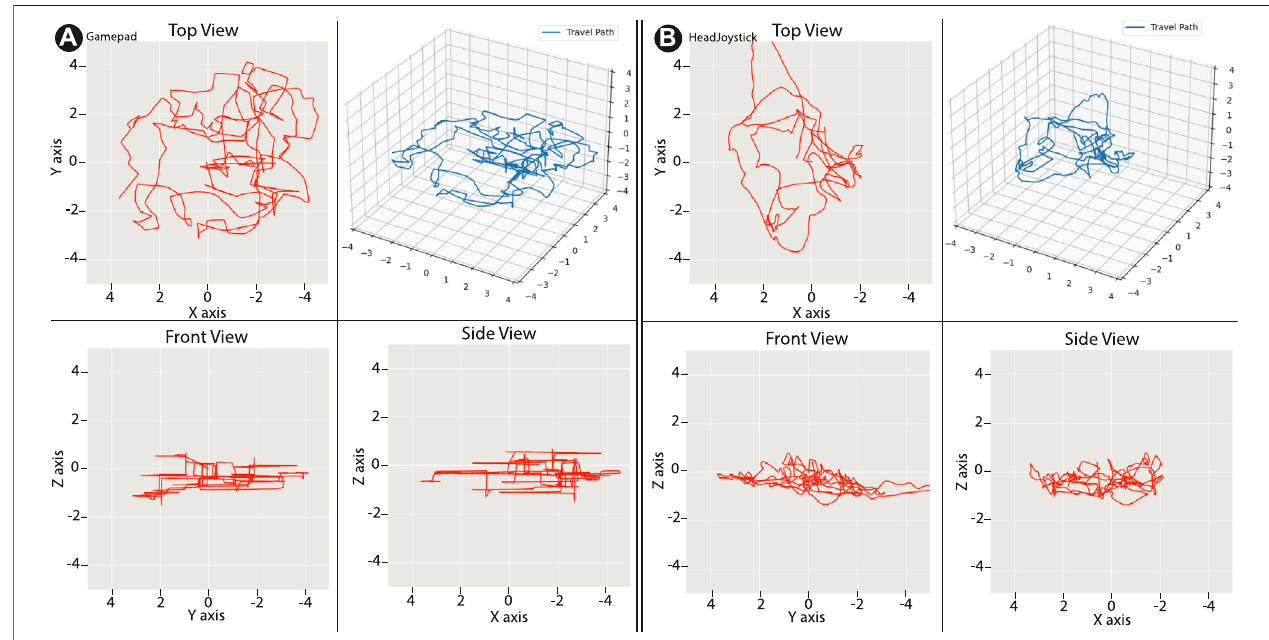
FIGURE 6 | Representative travel path (isometric, top, front and side) for (A) Gamepad and (B) HeadJoystick from a randomly selected participant.